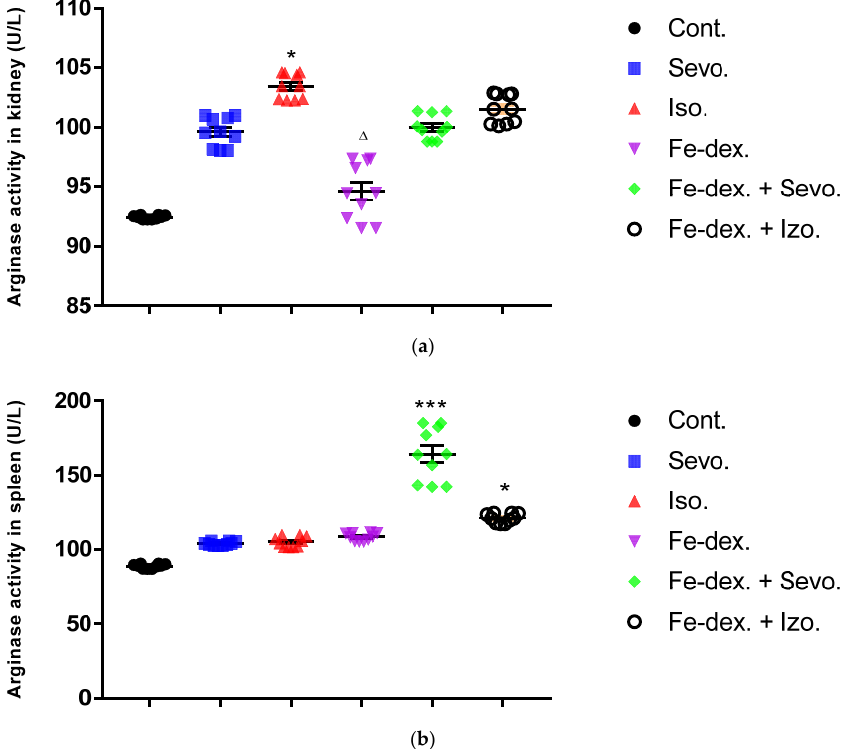
Figure 6. Effect of inhaled anesthetics and iron dextran on the arginase activity in kidney ( a ) and spleen ( b ) of rats treated for 28 days. Rats ( n = 10 per group) were treated with ip injection of iron dextran (50 mg/kg), exposed to 2.4 vol % sevoflurane inhalation and 1.3 vol % isoflurane inhalation, and exposed to a combination thereof where inhaled anesthetics were given 2 h after ip injection of iron dextran. Animals were treated every other day for 28 days. Each animal sample is indicated by a single dot. The results are expressed as the mean value of each experimental group ± SE. * Statistically significant compared to the control group (* p < 0.05; *** p < 0.001); ∆ Statistically significant compared to the isoflurane group ( ∆ p < 0.05). Abbreviations: Cont., control group; Sevo., sevoflurane group; Iso., isoflurane group; Fe-dex., iron dextran group; Fe-dex. + Sevo., group treated with iron dextran and sevoflurane; and Fe-dex. + Iso., group treated with iron dextran and isoflurane. Cytokines are secreted by cells of the immune system, and their primary role is me- diation and regulation among other participants in the immune system. In addition, they participate in the body’s defences by causing protective local inflammation that can have a systematic impact at the acute level. A total of 12 inflammatory cytokines from rat serum treated with inhaled anesthetics, iron dextran, and their combinations were analysed, and the results are shown in Figure 7.